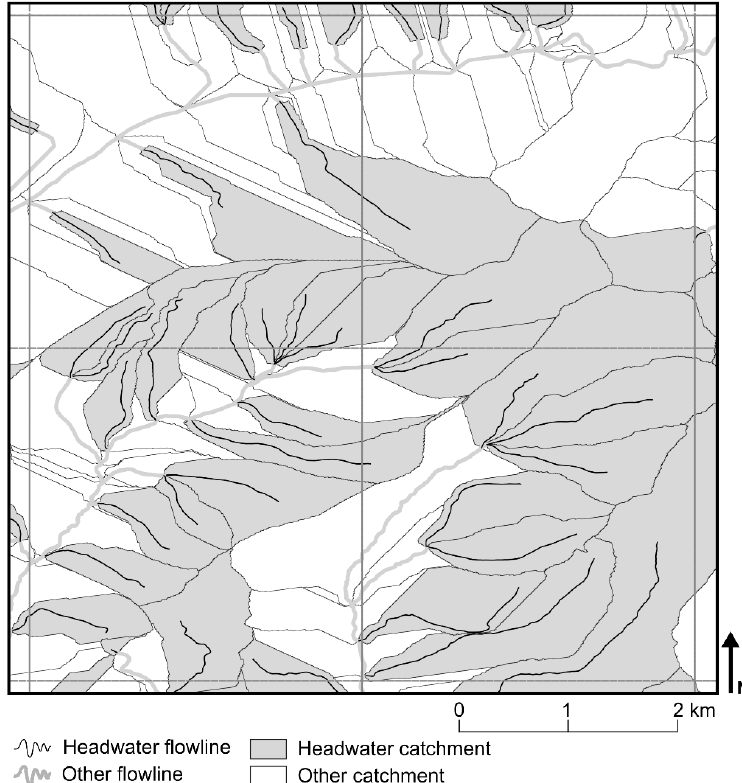
Figure 3. Example of catchments and stream segments that show the geospatial fabric to which the monthly water balance model was applied. Grid shows the extent of individual PRISM [39] grid cells (~4 km).